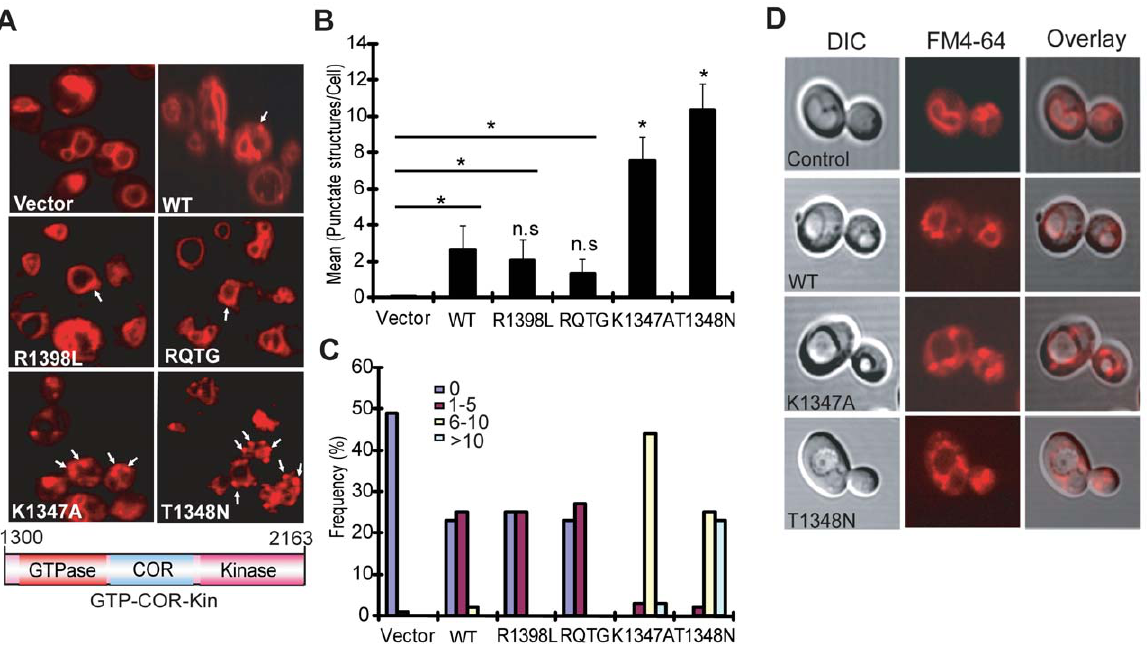
Figure 3. LRRK2 GTPase variants induce defects in endocytic vesicular trafficking. (A) Endocytosis of the lipophilic fluorescent dye FM4–64 (red) was employed to monitor the effects of LRRK2 GTPase variants (in the GTP-COR-Kin fragment) on vesicular trafficking to the vacuole in yeast. Cells carrying empty vector display normal ring-like vacuolar membrane staining (asterix). Expression of the GTPase mutants, K1347A or T1348N, markedly disrupts FM4–64 vacuole localization with the appearance of multiple large punctate structures (arrows). (B) Quantification of endocytic trafficking defect showing the average number of FM4–64-positive punctate structures per cell. A total of 100 cells were analyzed in one experiment and data are representative of at least two independent experiments. Bars represent the mean 6 SEM. Data were analyzed for statistical significance by two-tailed unpaired Student’s t -test relative to WT LRRK2, or by pair-wise comparisons with vector controls where indicated by horizontal lines (* P , 0.01). n.s. , non- significant versus WT. (C) Frequency distribution showing the percent (%) of cells with different numbers of FM4–64-positive punctate structures as a measure of endocytic trafficking defects between truncated LRRK2 GTPase variants. Data are taken from one experiment ( n =100 cells) and are representative of at least two independent experiments. (D) Yeast cells carrying LRRK2 GTPase variants have normal vacuolar morphology. DIC images are employed to visualize the morphology of vacuoles for each LRRK2 construct following galactose induction and FM4–64 staining.